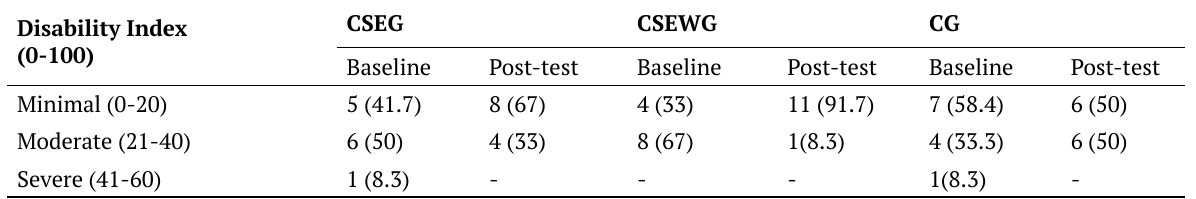
Table 3. Disability index of LBP by the groups and times (n &